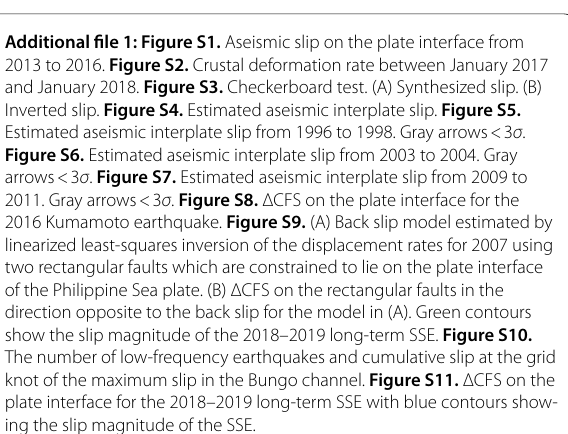
Additional file 1: Figure S1. Aseismic slip on the plate interface from 2013 to 2016. Figure S2. Crustal deformation rate between January 2017 and January 2018. Figure S3. Checkerboard test. (A) Synthesized slip. (B) Inverted slip. Figure S4. Estimated aseismic interplate slip. Figure S5. Estimated aseismic interplate slip from 1996 to 1998. Gray arrows < 3 σ . Figure S6. Estimated aseismic interplate slip from 2003 to 2004. Gray arrows < 3 σ . Figure S7. Estimated aseismic interplate slip from 2009 to 2011. Gray arrows < 3 σ . Figure S8. ΔCFS on the plate interface for the 2016 Kumamoto earthquake. Figure S9. (A) Back slip model estimated by linearized least-squares inversion of the displacement rates for 2007 using two rectangular faults which are constrained to lie on the plate interface of the Philippine Sea plate. (B) ΔCFS on the rectangular faults in the direction opposite to the back slip for the model in (A). Green contours show the slip magnitude of the 2018–2019 long-term SSE. Figure S10. The number of low-frequency earthquakes and cumulative slip at the grid knot of the maximum slip in the Bungo channel. Figure S11. ΔCFS on the plate interface for the 2018–2019 long-term SSE with blue contours show- ing the slip magnitude of the SSE. Abbreviations GNSS: Global Navigation Satellite System; SSE: Slow slip event; ΔCFS: Coulomb failure stress change; Mw: Moment